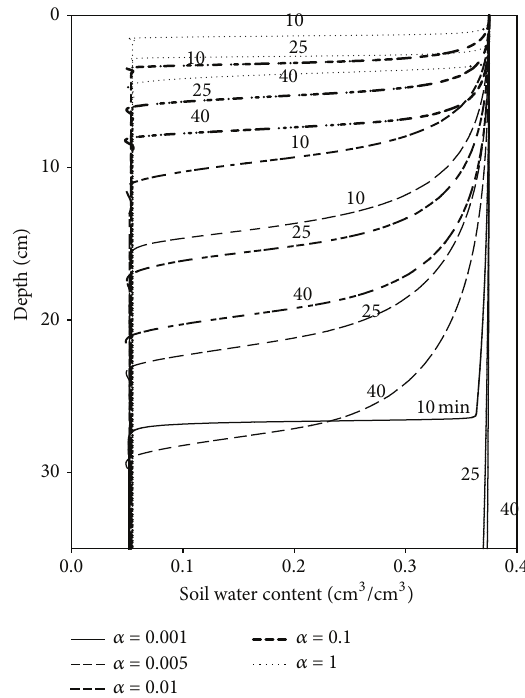
Figure 5: Simulated soil water content profiles after different infiltration times (10, 25, and 40min) for different values of the 𝛼 parameter in the model.